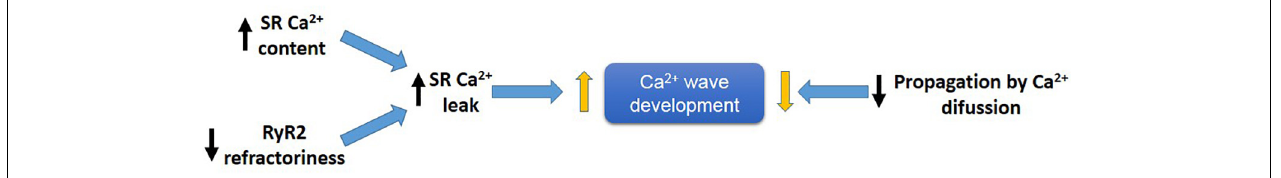
FIGURE 7 | Main factors developing arrhythmogenic Ca 2 + waves. An increase in SR-Ca 2 + content and/or a decrease in RyR2 refractoriness favor SR-Ca 2 + leak and Ca 2 + wave generation, meanwhile a decrease in propagation of Ca 2 + by diffusion (e.g., like that produce by PLN ablation), will prevent Ca 2 + wave propagation by conversion of Ca 2 + waves into non-propagable Ca 2 +